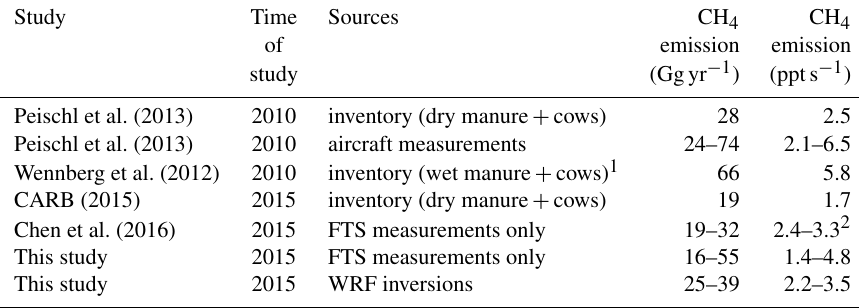
Table 1. Emissions of CH 4 at Chino.